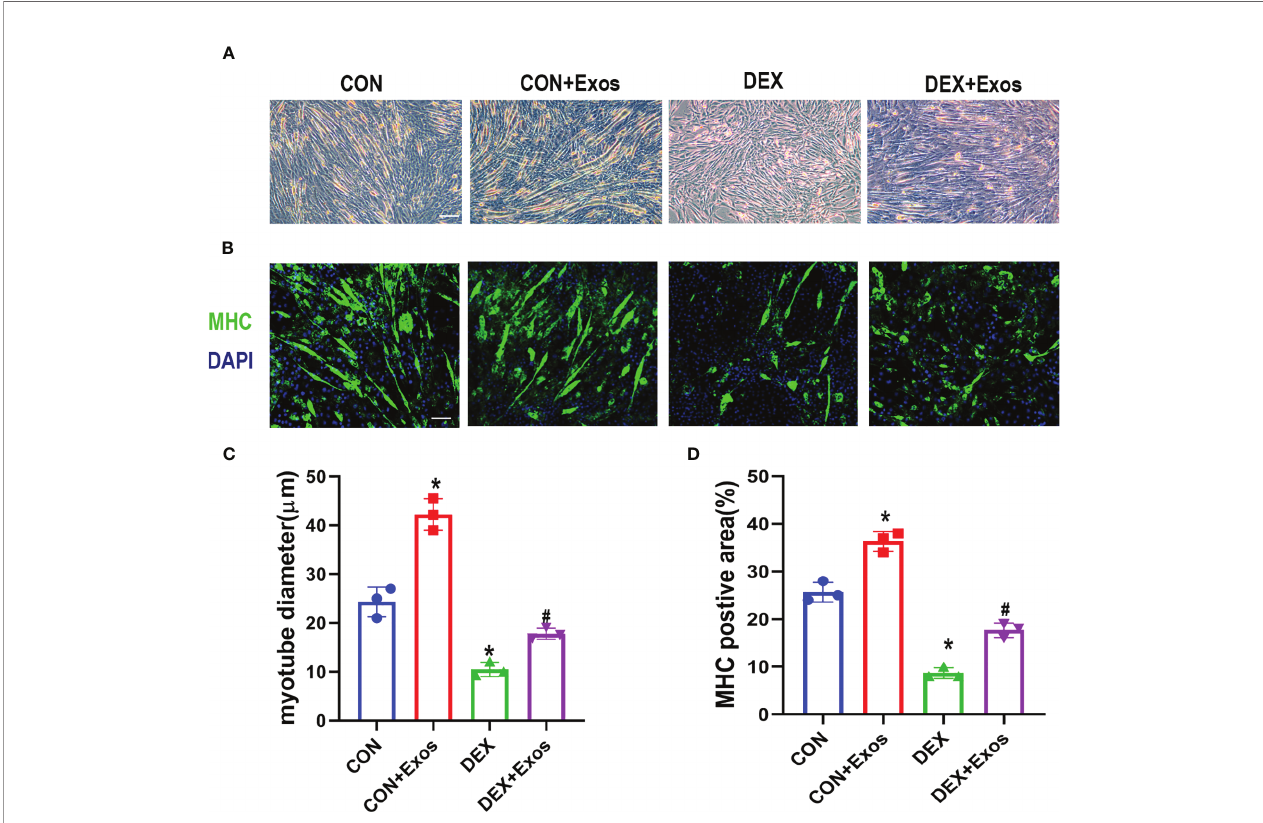
FIGURE 2 | Exosomes derived from BMSCs inhibited DEX-induced myotube atrophy. (A) Representative images of C2C12 myotubes under the treatment of DEX and BMSC-Exos. Scale bar = 50µm (B) Immuno fl uorescence staining of Myosin high chain (MHC) in C2C12 cells with the treatment of DEX and BMSC-Exos. Scale bar = 50µm. (C) The myotube diameters among different groups were quanti fi ed (n = 3). (D) The MHC positive area among different groups were quanti fi ed (n = 3). *p < 0.05 compared to the control group, # p < 0.05 compared to the DEX